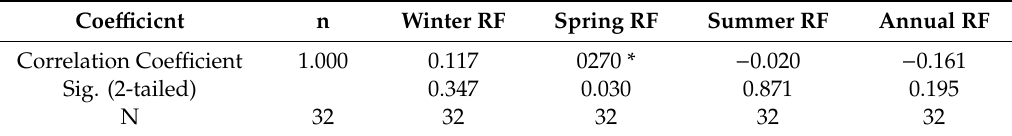
Table 3. Mann–Kendall’s rank test result for inter-annual rainfall